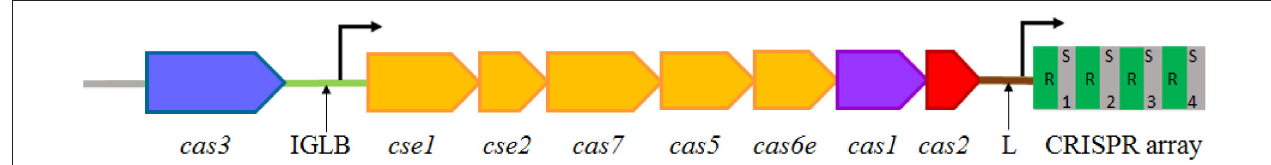
FIGURE 1 | A scheme of a Type I-E CRISPR-Cas system from E coli (Al-Attar et al., 2011; Makarova et al., 2011, 2015). The cas genes and the CRISPR array are indicated. R and S within the CRISPR array correspond, respectively, to repeats and spacers; note that the spacer sequences differ from each other, and are labeled by consecutive numbers (1, 2, 3...). IGLB and L correspond to intergenic regions where promoters for the Cascade complex genes ( cse1,2 , cas7,5,6e ) and the Cas1,2 adaptation proteins (IGLB) and the CRISPR array (L) are located. The two promoters within IGLB and L are indicated by arrows. One of the Cas